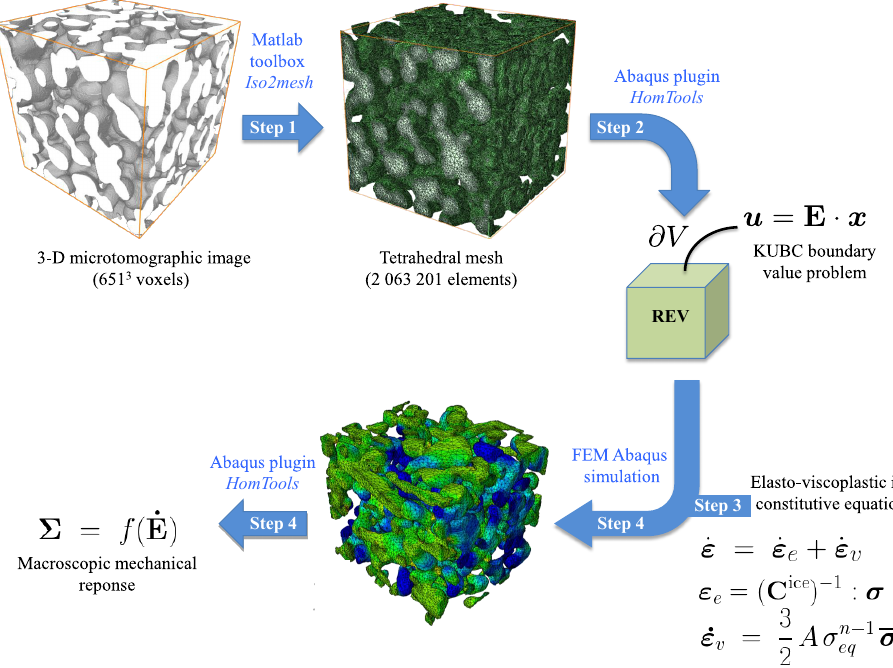
Figure 1. Four-step procedure used in order to transform 3-D microtomograph images of snow into finite element models and numerically solve KUBC homogenization boundary value problems.